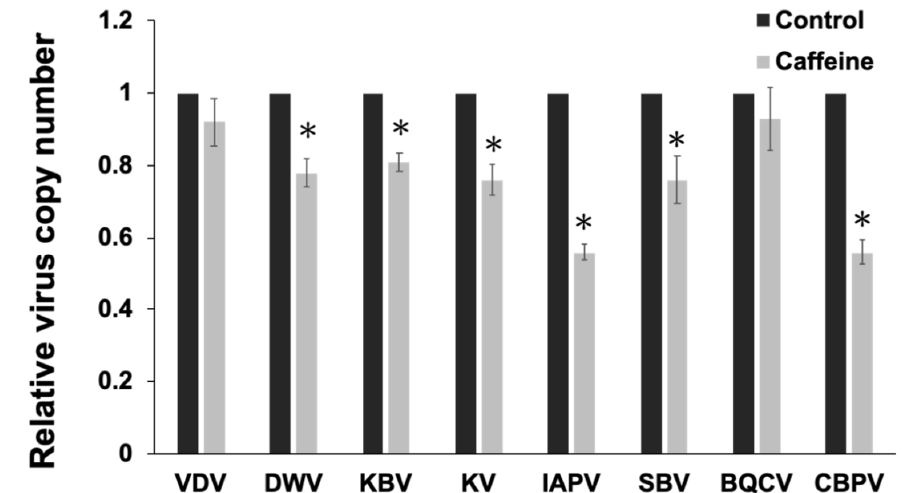
Figure 3. Ca ff eine suppresses pathogen amplification in infected honeybees of mixed group. Replicative Figure 3. Caffeine suppresses pathogen amplification in infected honeybees of mixed group. analysis of viruses in honeybees. Relative viral DNA replication was analyzed by real-time